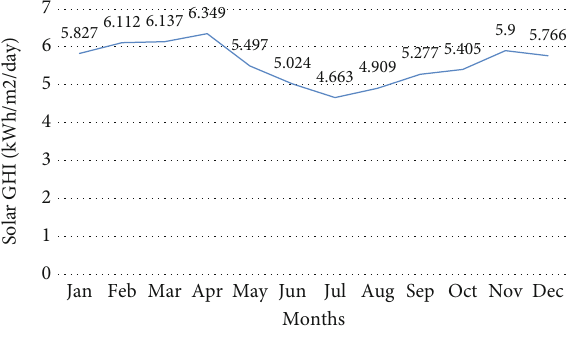
Figure 39: Monthly solar Global Horizontal Irradiation (GHI kWh/m 2 /day) for South Sudan.